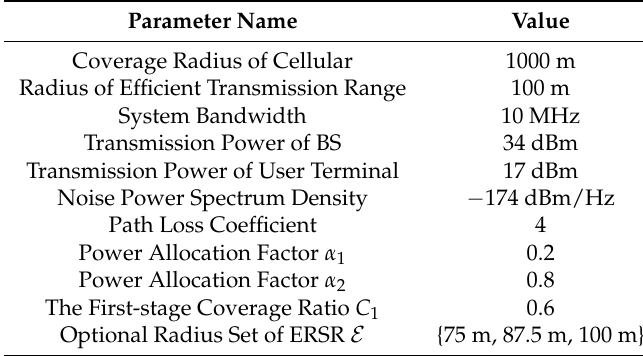
Table 2. Simulation